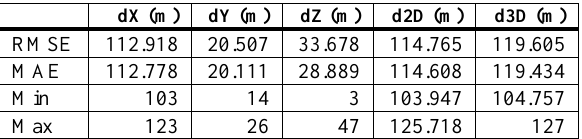
Table 1. Statistical parameters in the case of applying coarse